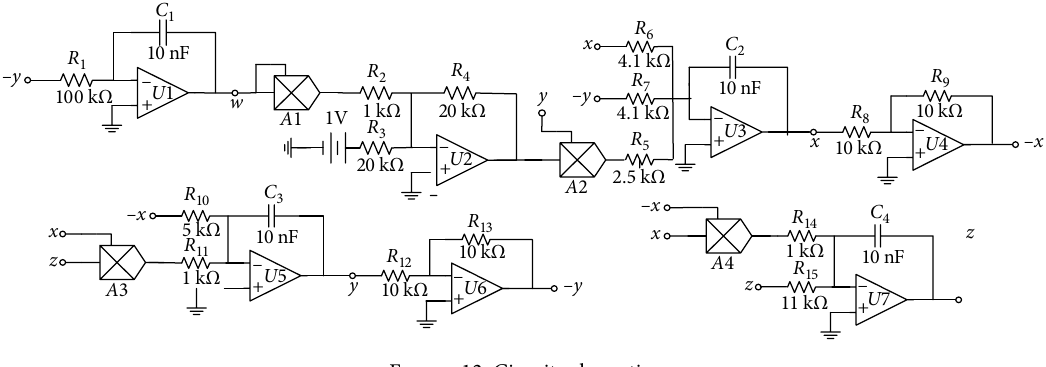
Figure 12: Circuit